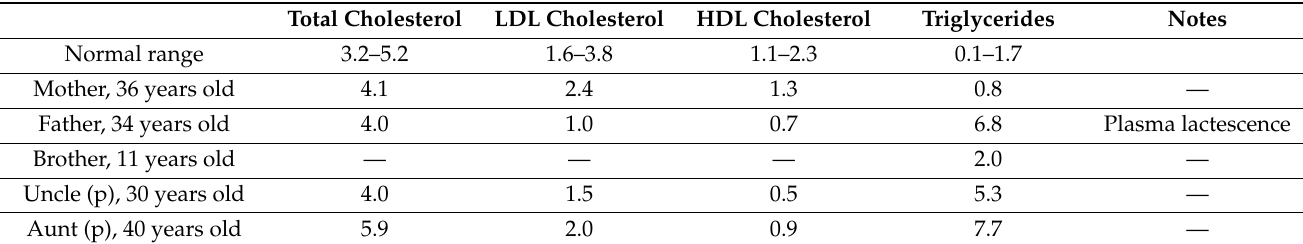
Table 1. Lipid levels in patient’s